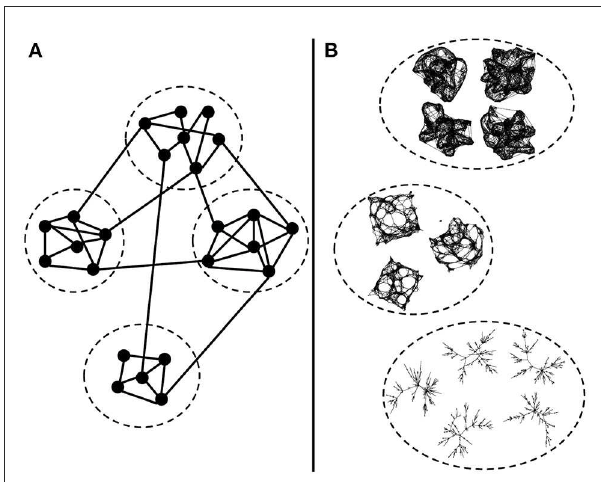
FIGURE1 Clustering network strategies. (A) Usual graph clustering methods: cluster vertices of a graph into subgraphs. Highly connected vertices form one cluster. (B) Our goal: cluster graphs into groups of similar connectivity structures. In this example, we have graphs generated by three different random graph models. Graphs of the same model and set of parameters belong to the same